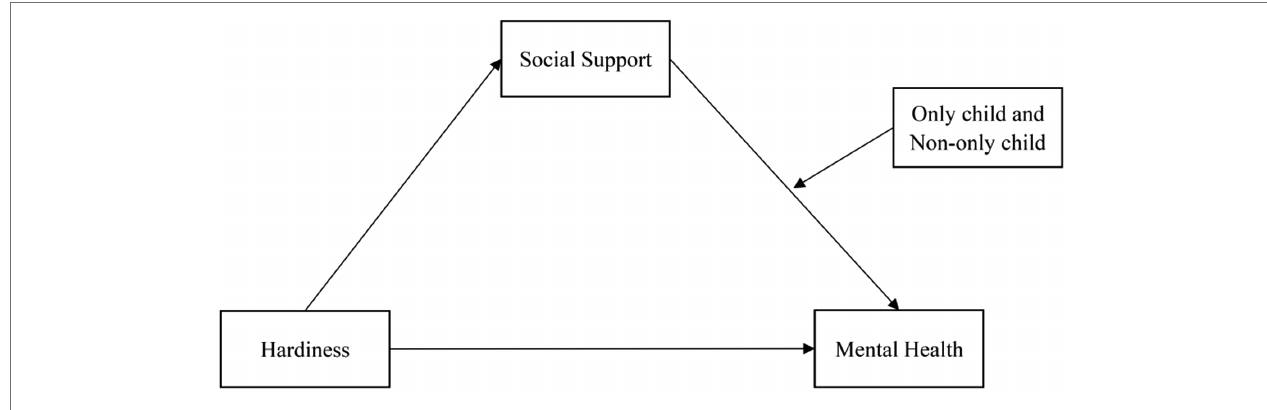
FIGURE 1 | Hypothetical